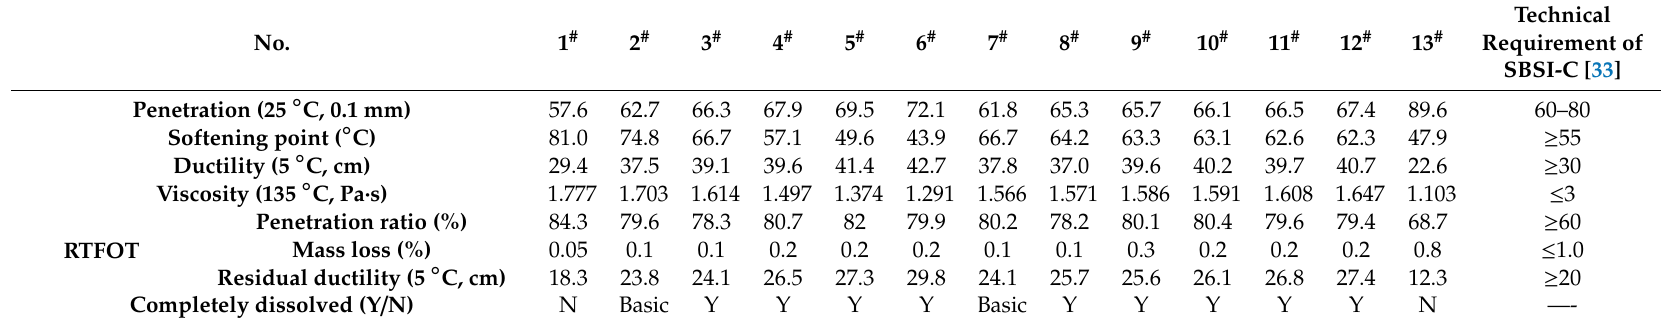
Table 5. Performances of modified bitumen by direct-to-plant SBS.